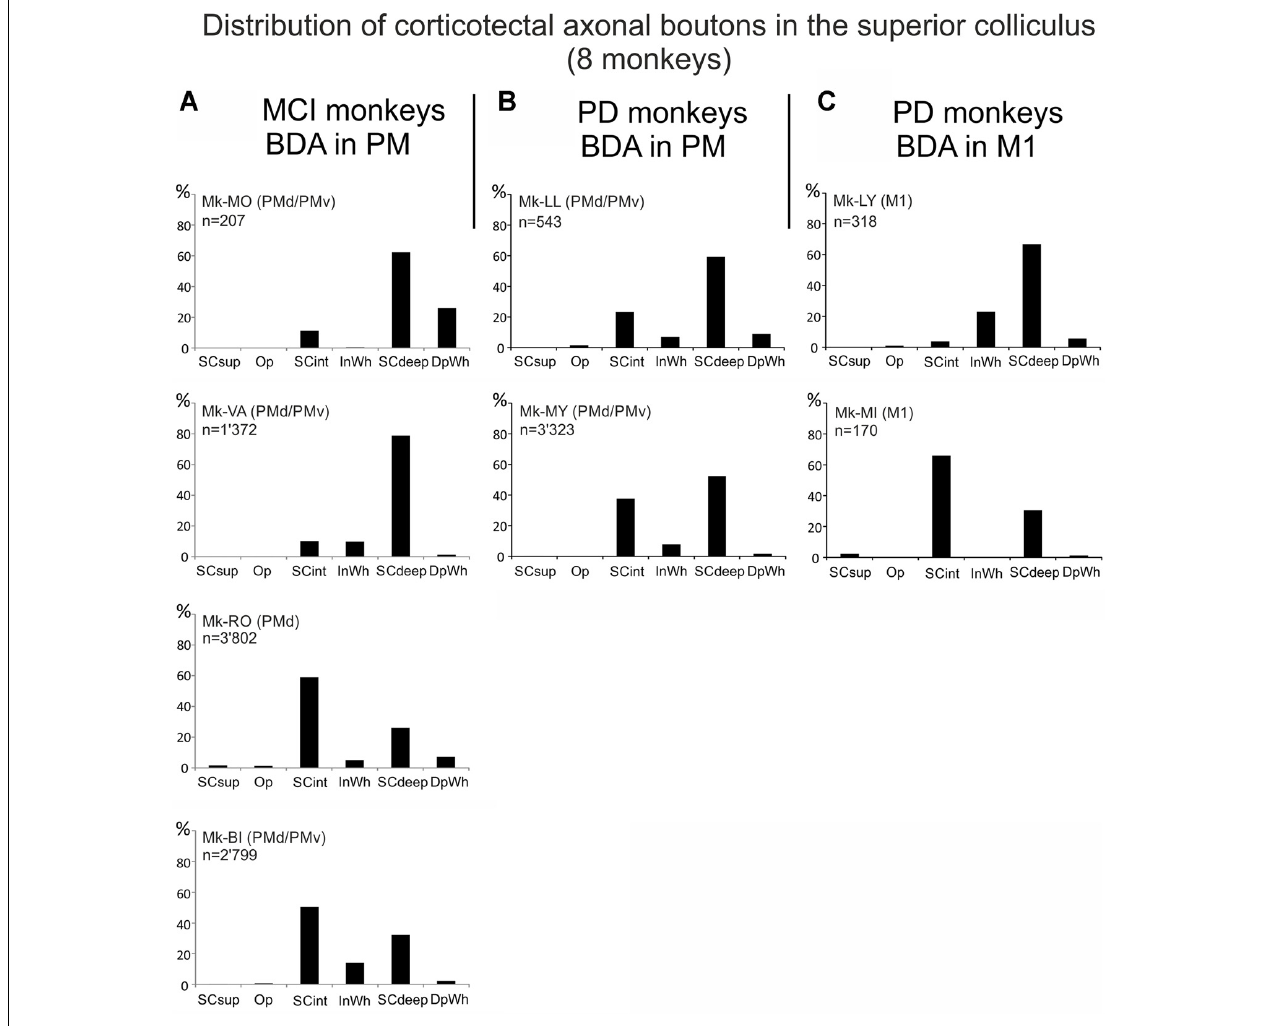
FIGURE 4 | Distributions of the numbers of BDA-labeled corticotectal axonal boutons both en passant and terminaux in the ipsilateral SC, across the different SC layers in each monkey (see “List of Abbreviations”), subjected to cortical lesion of the hand area in M1 motor cortex injury (MCI, A ), or to MPTP intoxication (PD, B,C ). In (A) , the top two monkeys were treated with the anti-Nogo-A antibody, whereas the bottom two monkeys were untreated. In panels (B,C) , all monkeys were autologous neural cell ecosystems (ANCEs) treated. In each graph, the sum of all bins is